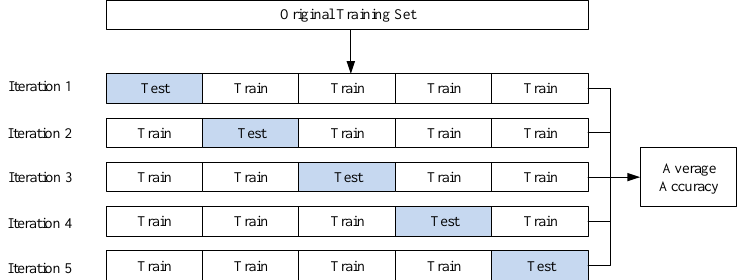
Figure 17. Diagram of five-fold cross-validation.